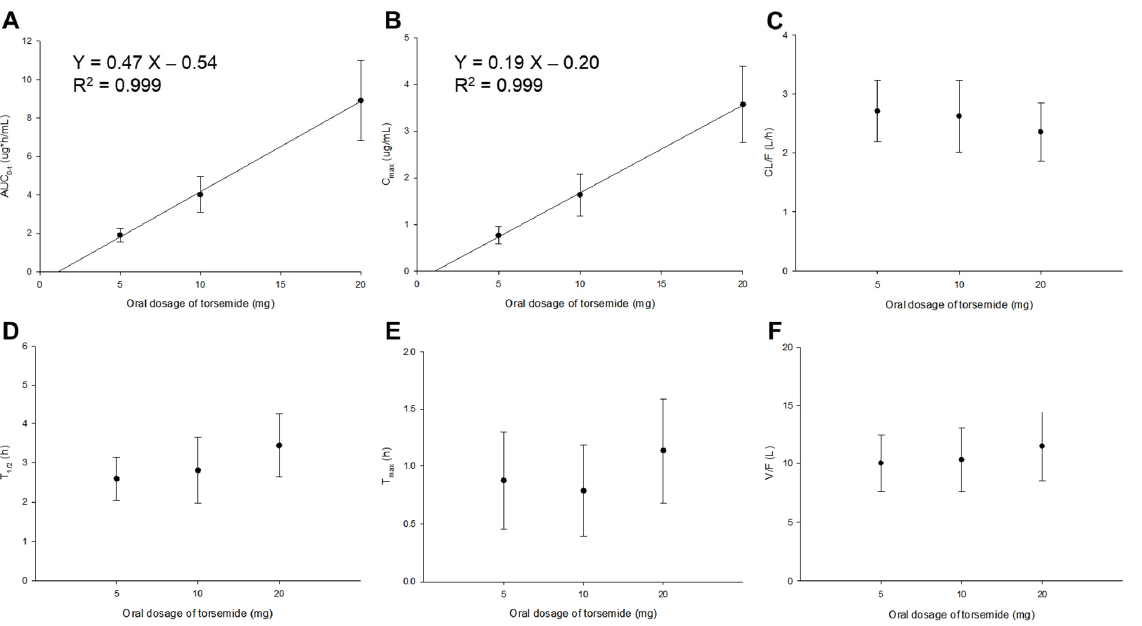
Figure 2. Graphs of changes in PK parameters (AUC 0–t ( A ); C max ( B ); CL/F ( C ); T 1/2 ( D ); T max ( E ); V/F ( F )) by dose according to oral administration of torsemide in healthy Korean men. PK parameters were calculated by NCA. Vertical bar represents the SD at each point.